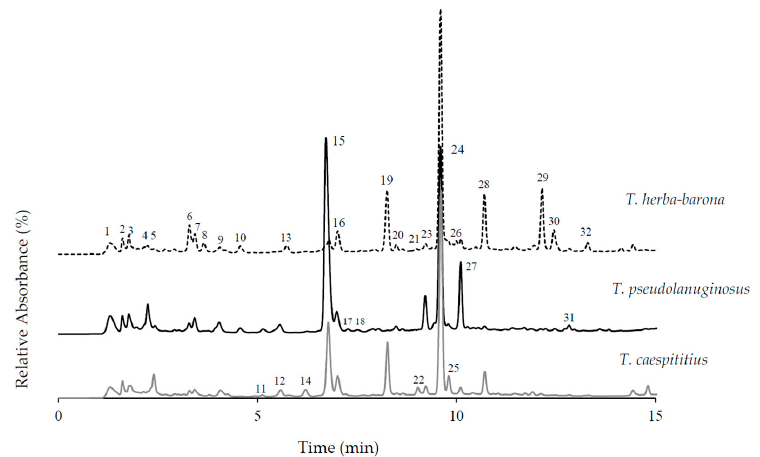
Figure 1. Chromatographic profiles at 280 nm of T. herba-barona , T. pseudolanuginosus , and T.